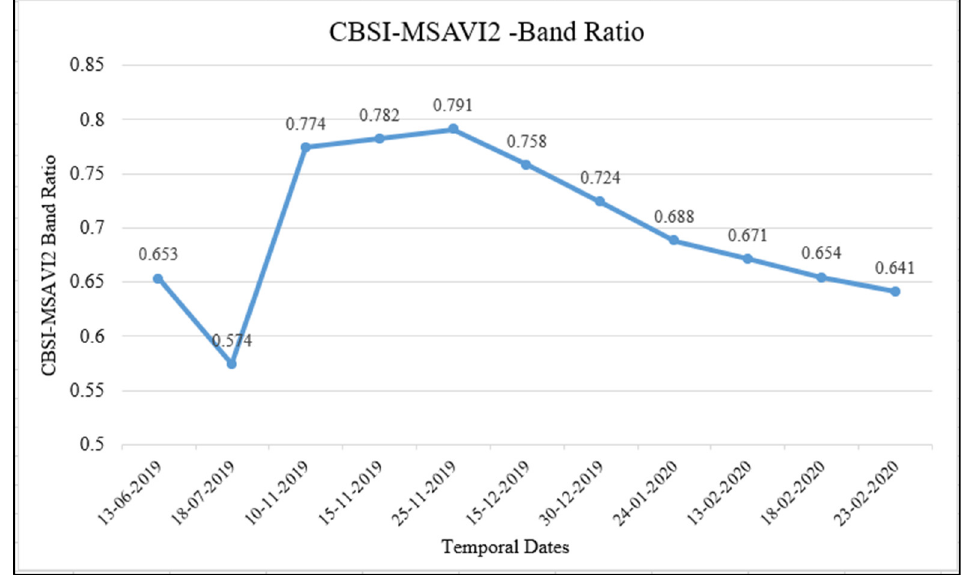
Figure 3. Graph of CBSI-MSAVI2 indices versus temporal dates.